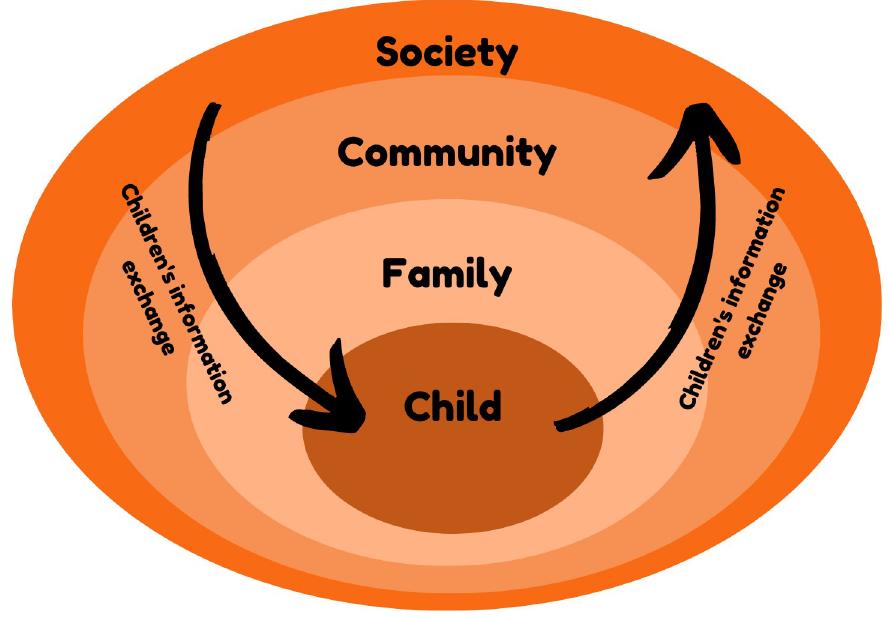
Fig 1. Children’s information exchange in relation to